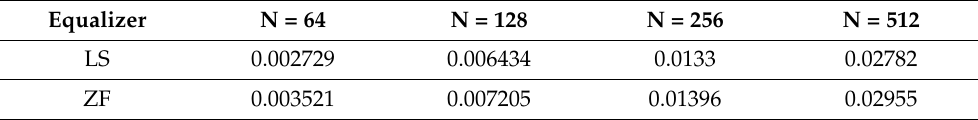
Table 2. BER performance for 64, 128, 256, and 512 subcarriers at a fixed distance of 500